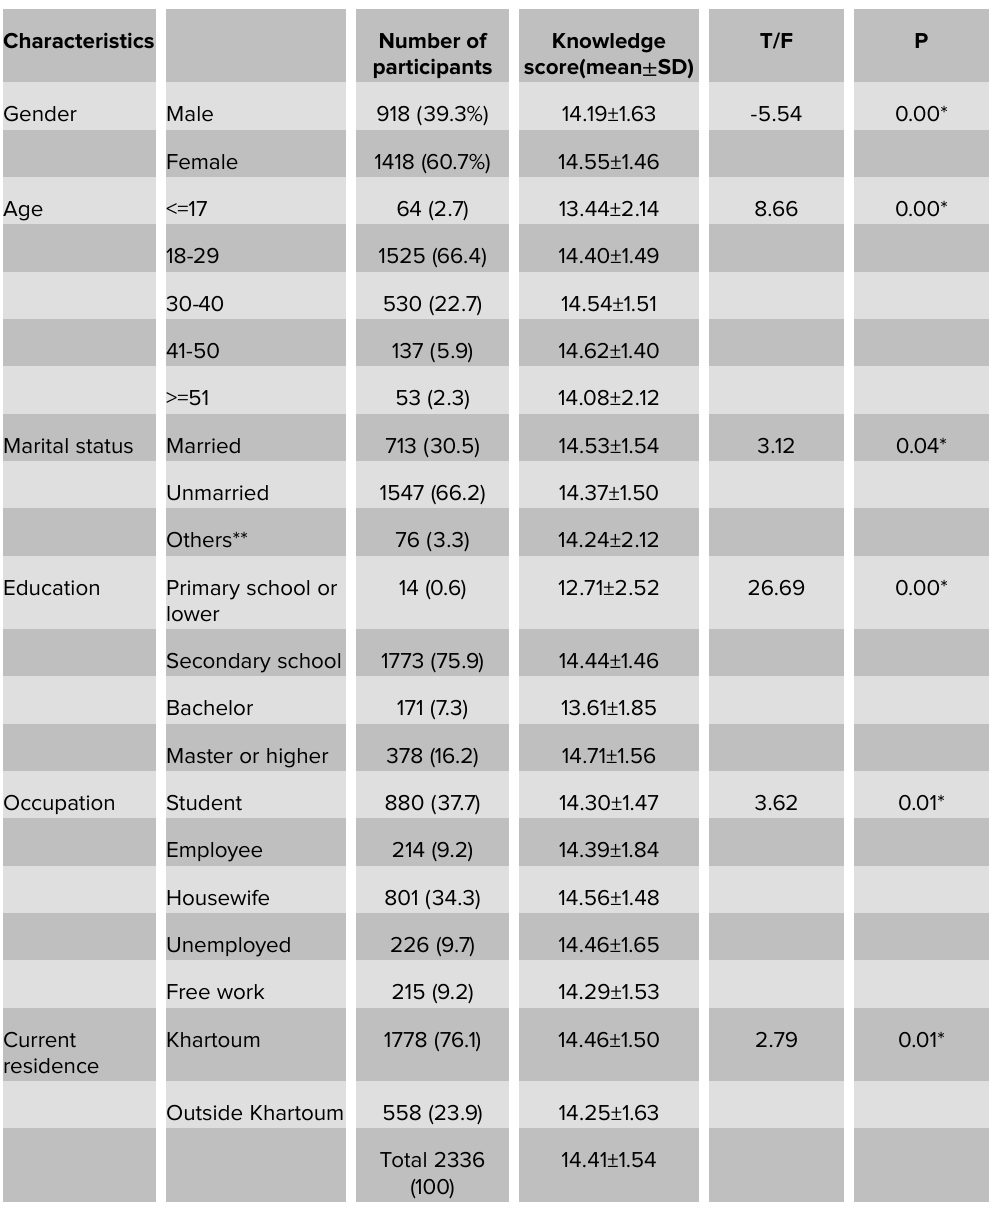
TABLE 2: Demographic features of participants and the knowledge score of COVID-19 by demographic variables. (n=